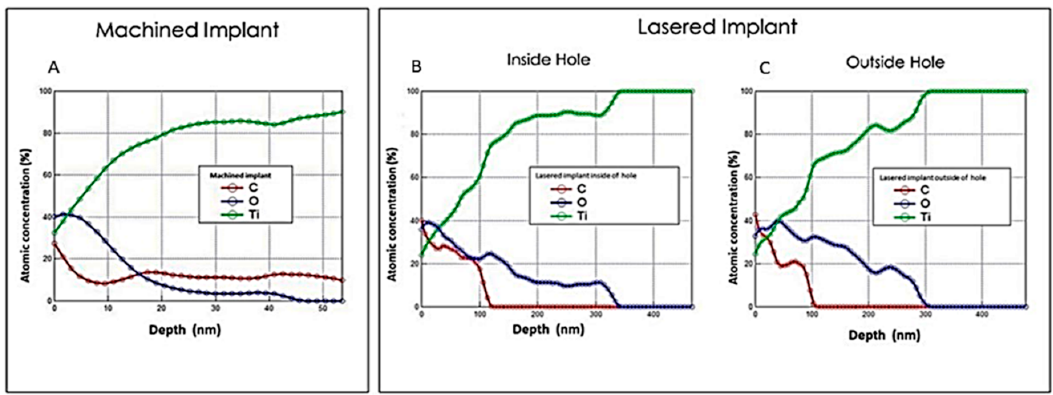
Figure 2. ( A ) concentration profile with varying depth for the machined implant. Concentration profile with varying depth for the Lasered implant. ( B ) Inside a hole. ( C ) Outside a hole.